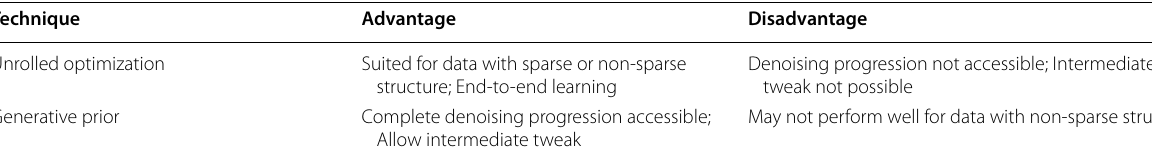
Table 2 Comparison between hybrid denoising techniques Technique Advantage Disadvantage Unrolled optimization